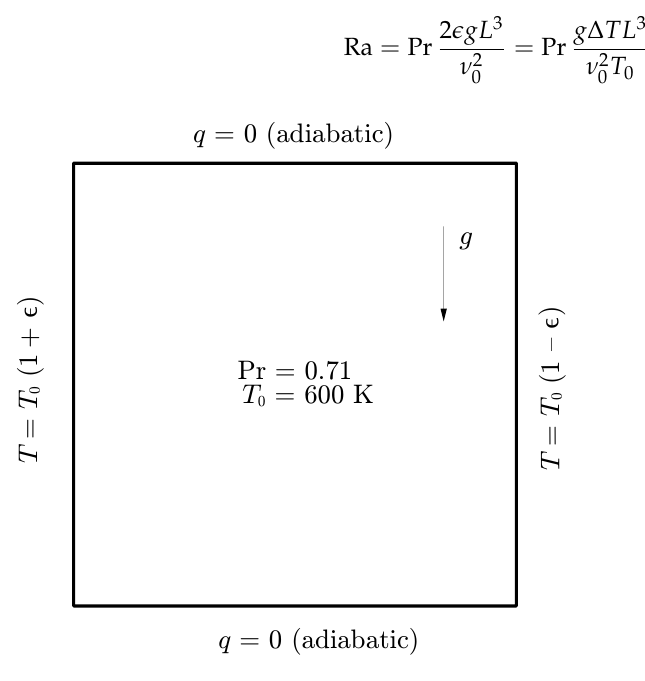
Figure 1. Buoyancy-driven square cavity. Problem